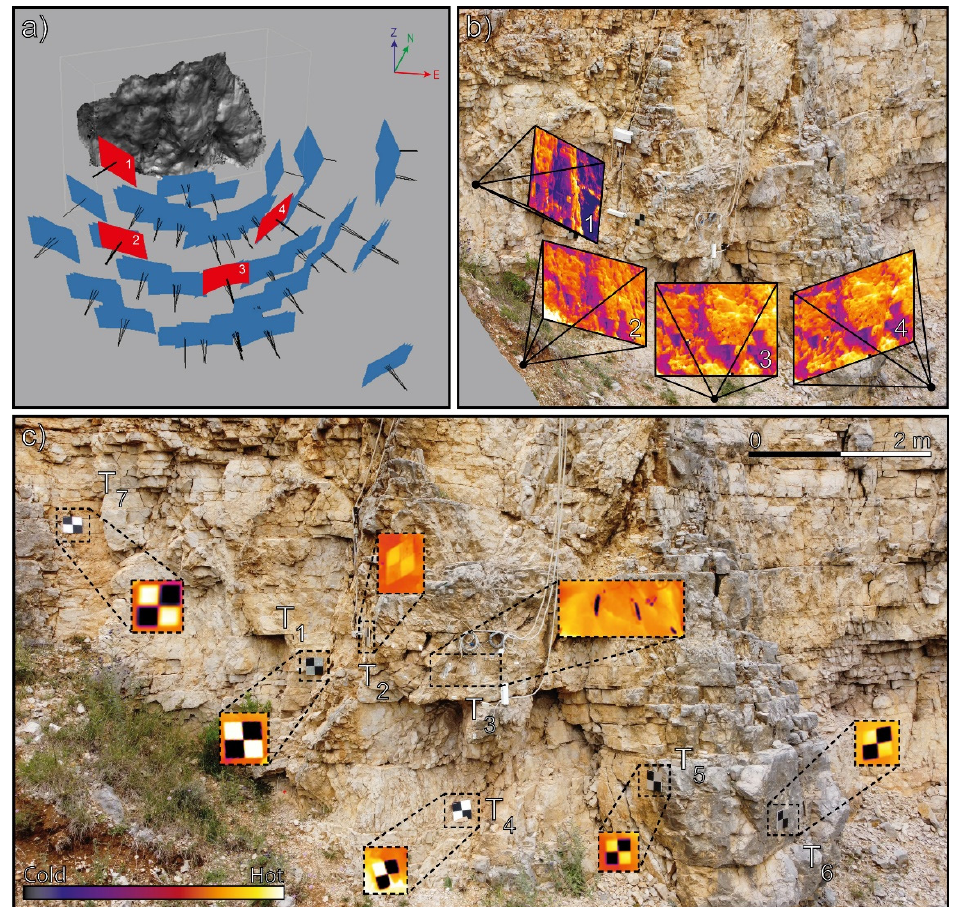
Figure 3. ( a , b ) An example of the standardized imagery acquisition method used for the 3D point cloud reconstruction of the rock block from TIR images. ( c ) Front view of the rock block and the adjacent rock wall where the cold thermal signatures related to the highly reflective GCPs (Tx) are clearly visible.